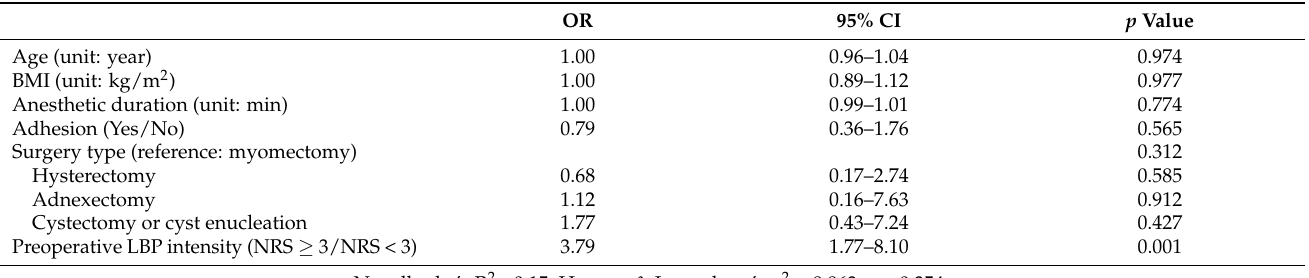
Table 1. Binary logistic regression to evaluate the effect of variables on the probability of moderate- to-severe pain in the recovery room.